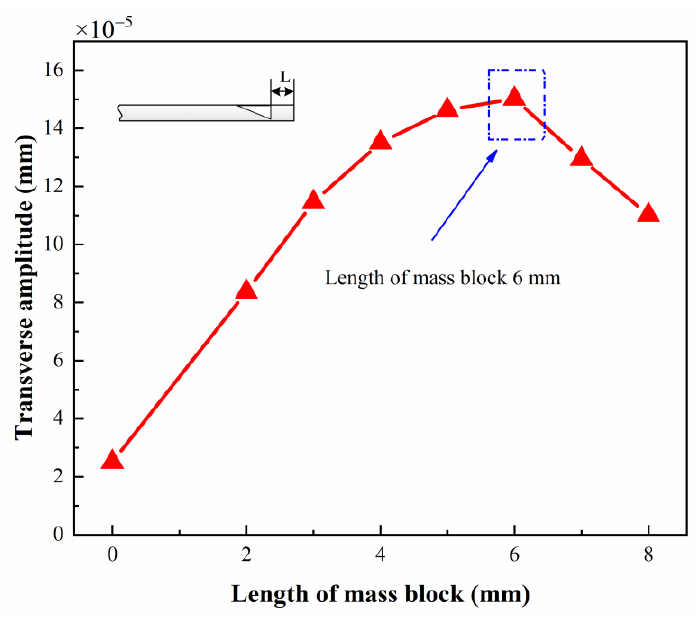
Figure 13. Transverse amplitudes with different inertia masses.